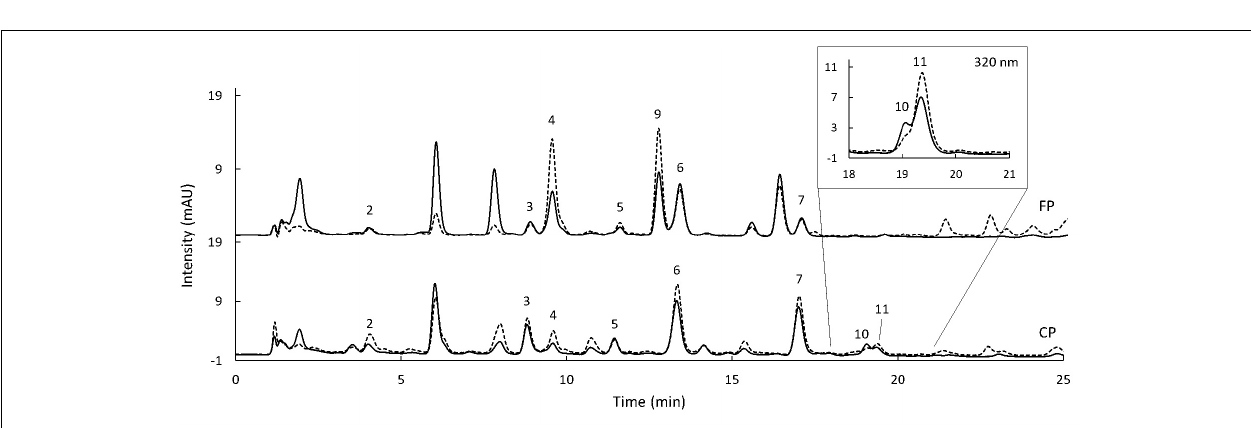
FIGURE 5 | HPLC chromatogram of free (FP, upper chromatogram) and conjugated (CP, lower chromatogram) phenolic acids extracted from Kalatur (solid line) and Huggo (dash line) was recorded at 268 nm. Peaks 10 and 11 (CP) is shown also at 320 nm (from 18 to 21 min). 2: protocatechuic acid, 3: vanillic acid, 4: caffeic acid, 5: syringic acid, 6: P -coumaric acid, 7: ferulic acid, and 9, 10, 11: peaks tentatively identified (see section “Discussion”). Injection volume: 10 µ l.